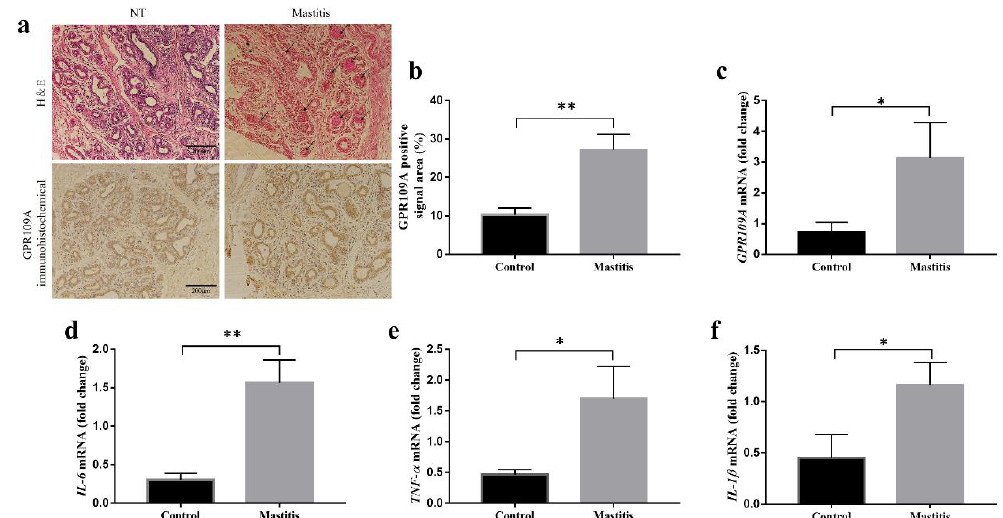
Figure 1. The relative expression of GPR109A, IL-6, TNF- α , and IL-1 β . The mammary glands were collected from healthy dairy cows and mastitis dairy cows ( n = 6). ( a , b ) The results of hematoxylin and eosin (H&E) staining and immunohistochemistry assays in the control and mastitis dairy cows. ( c ) The gene levels of GPR109A in the control and mastitis dairy cows. ( d – f ) The expression of pro-inflammatory factors in the control and mastitis dairy cows. The mRNA levels of GPR109A ( g ), IL-6 ( d ), TNF- α ( e ), and IL-1 β ( f ) were normalized to the level of β -actin . The values are presented as the means ± SD ( ∗ p ＜ 0.05 and ∗∗ p ＜ 0.01).